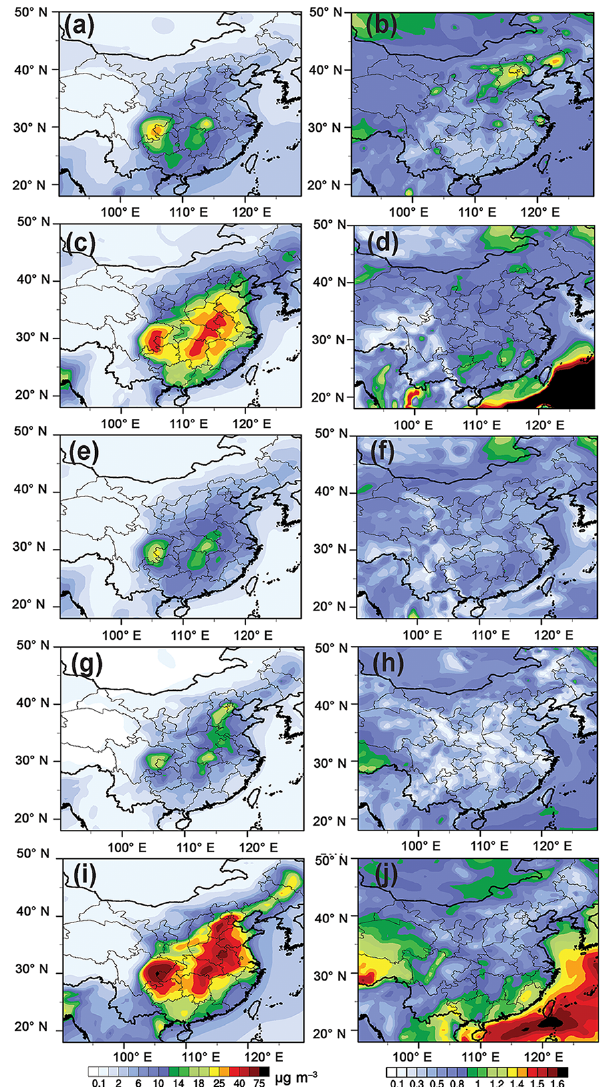
Figure 10. The ensemble mean monthly averaged near-surface dis- tributions of PM 2 . 5 compositions for January 2010 (sulfate (a) , ni- trate (c) , ammonium (e) , BC (g) , and OC (i) ), along with the spatial distribution of the coefficient of variation ( b , d , f , h , and j , SD di- vided by the average).